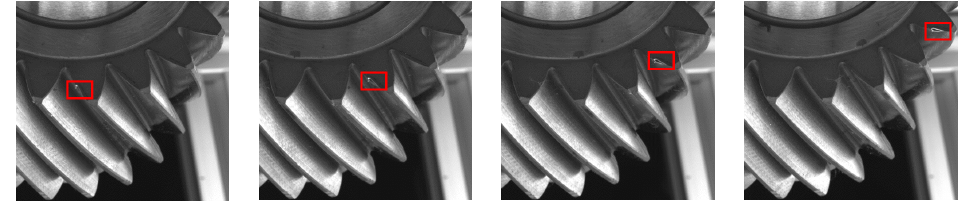
Figure 3. The same damaged teeth defect remains visible to the camera as the gear is rotated during inspection starting from the left most image to the right most